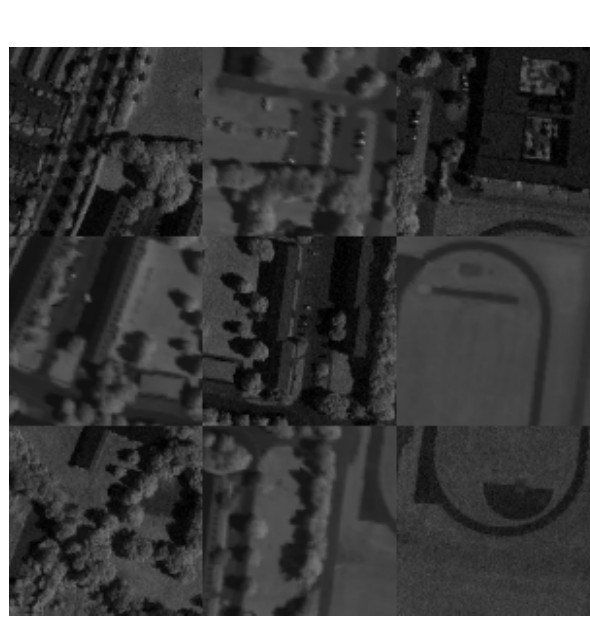
Figure 2: Subsection of uncalibrated SWIR and VNIR scenes Table 1: HySpex